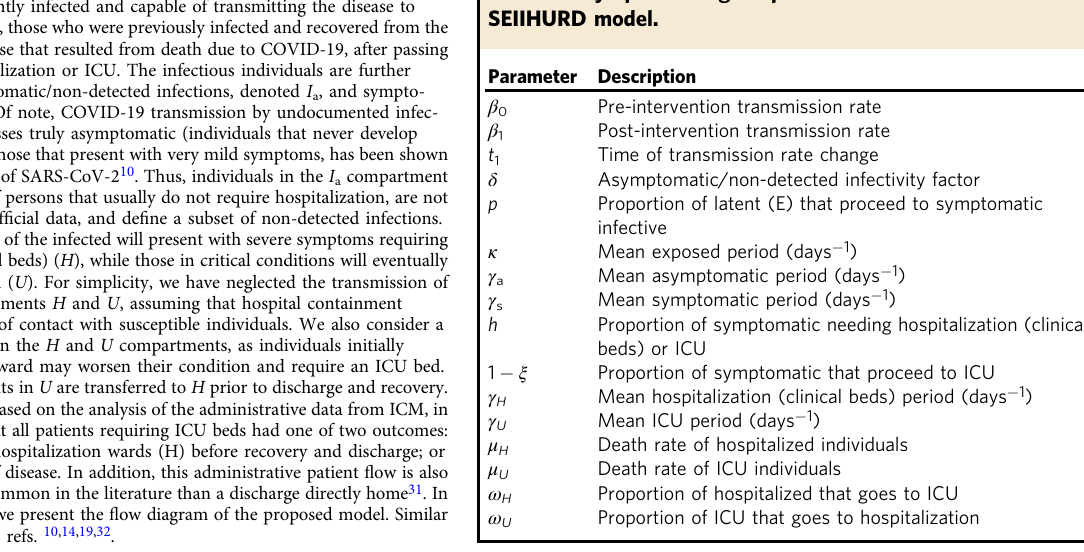
Table 3 Key epidemiological parameters used in the SEIIHURD